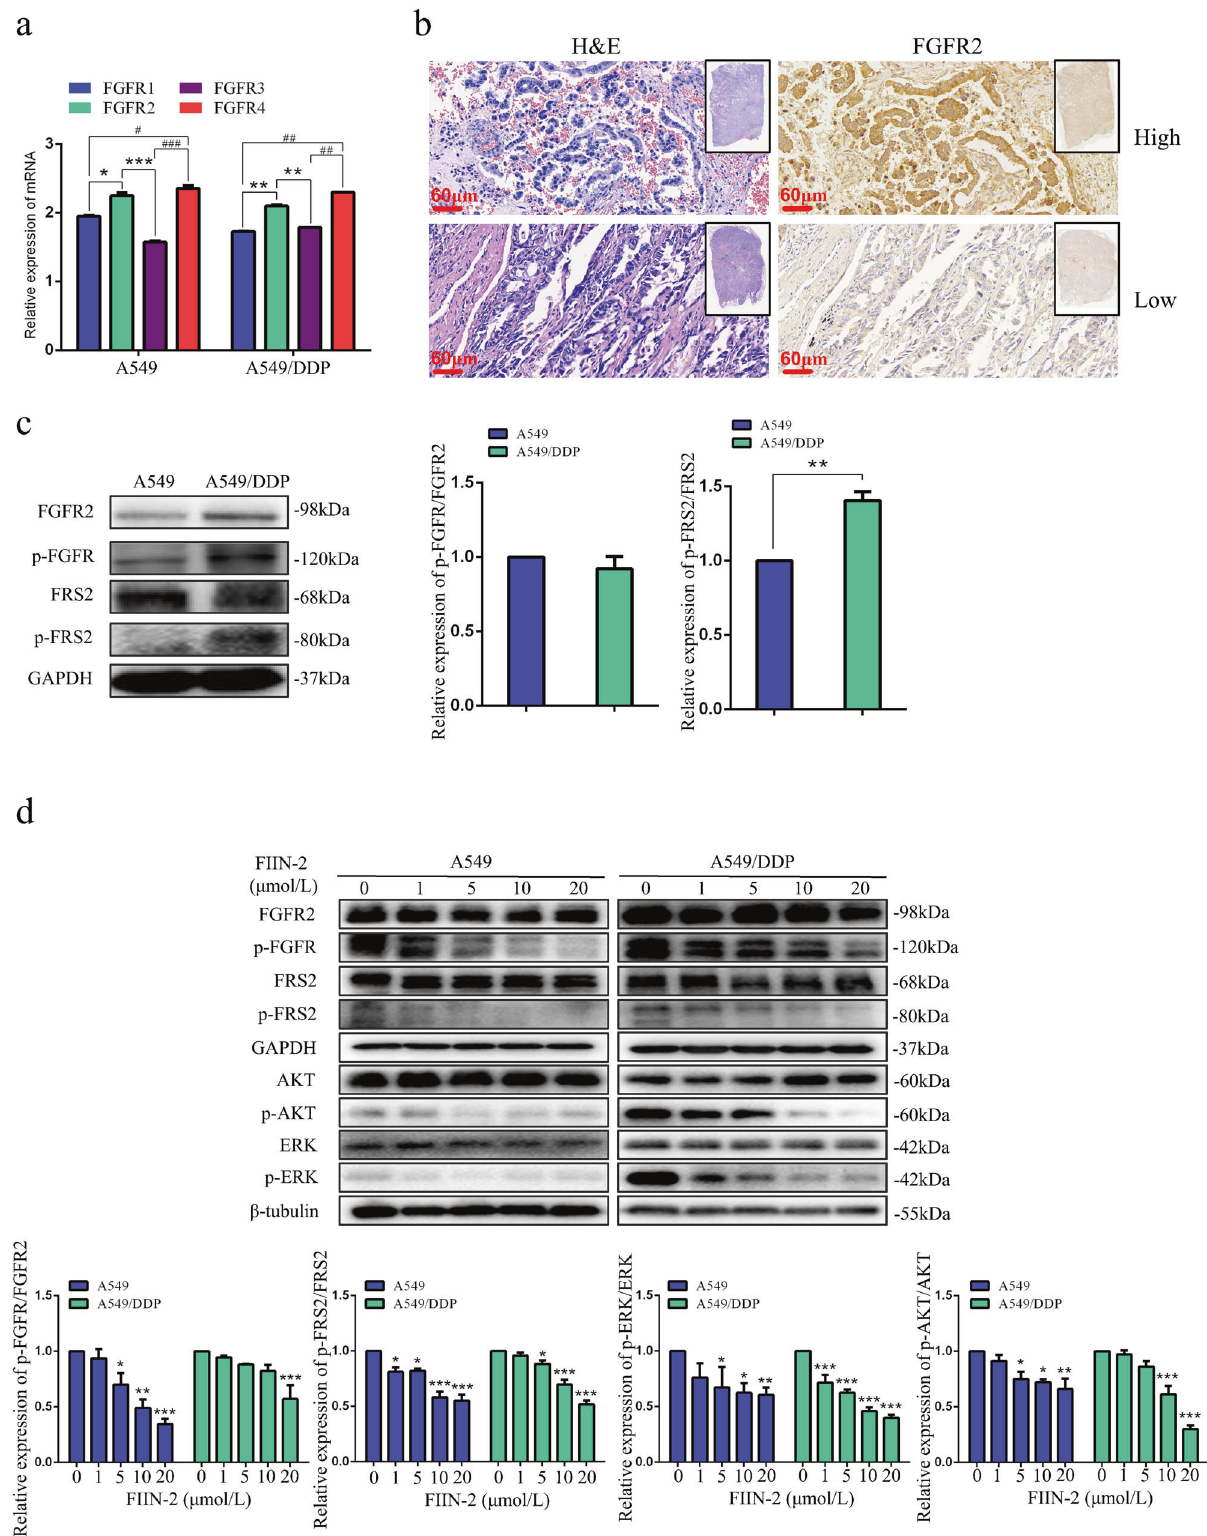
Fig. 1 The effect of FIIN-2 on FGFR-dependent signalling proteins in A549 and A549/DDP cells. a The mRNA levels of FGFR1-4 in A549 and A549/DDP cells were detected by RT-qPCR. b Representative immunohistochemistry images of lung adenocarcinoma (LUAD) tissues with high or low expression of FGFR2. The same tissue was stained with haematoxylin and eosin (H&E) (scale bar: 60 μ m, 200×). c The expression of FGFR2 and FGFR-dependent signalling proteins in A549 and A549/DDP cells. d The effects of FIIN-2 on FGFR2 and FGFR-dependent signalling proteins in A549 and A549/DDP cells were detected by western blot analysis. GAPDH and β -tubulin were used as the loading controls. Each bar corresponds to the mean ± SD of three independent experiments. * p < 0.05, ** p < 0.01, *** p < 0.001; # p < 0.05, ## p < 0.01, ### p < 0.001.